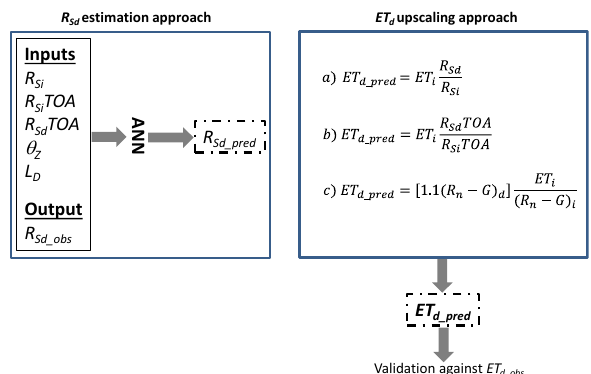
Figure 1. A conceptual diagram of the methodology. On the left side is a representation of predicting daily incoming shortwave ra- diation ( R Sd_pred ) . The ANN is trained to learn the system response to a combination of explanatory variables (i.e. instantaneous in- coming shortwave radiation ( R Si ) , instantaneous exo-atmospheric shortwave radiation ( R Si TOA), daily exo-atmospheric shortwave radiation ( R Sd TOA), solar zenith angle ( θ Z ) , and day length ( L D ) ) by being fed with a sample data of observed daily incoming short- wave radiation ( R Sd_obs ) which is the dependant variable. On the right side are methods of upscaling instantaneous (ET i ) to daily ET (ET d ) using our R S -based method (a) and the other two approaches ( b , c ) are the R STOA - and EF-based methods respectively, which are used for comparison of R s -based